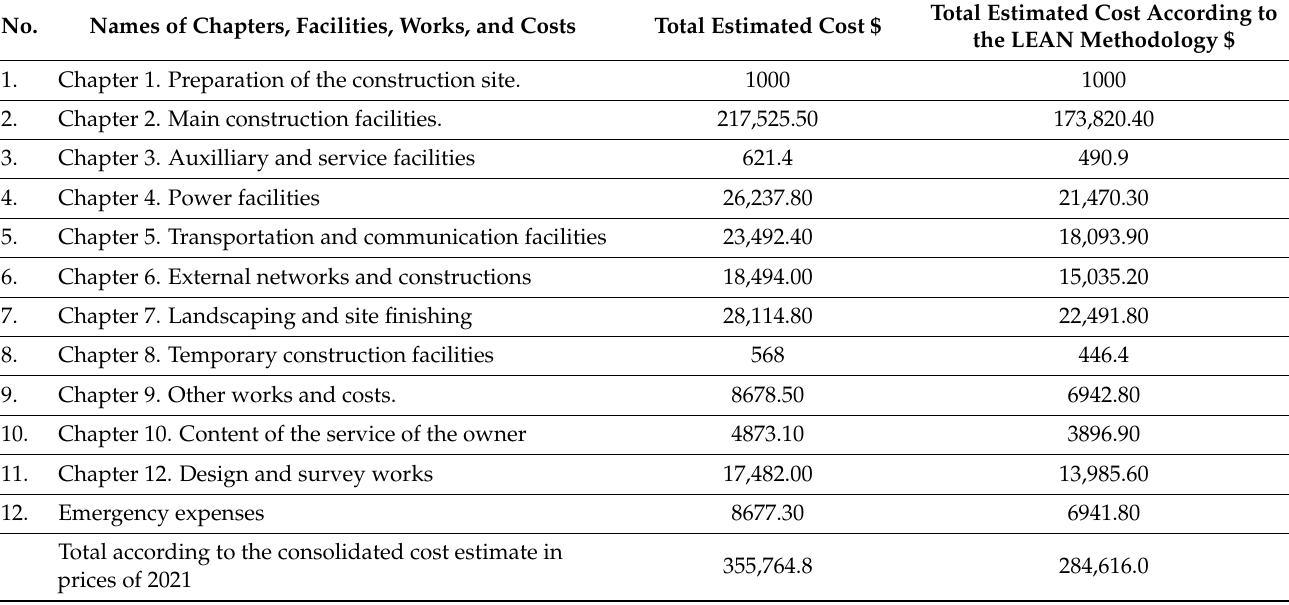
Table 10. Construction cost estimate.